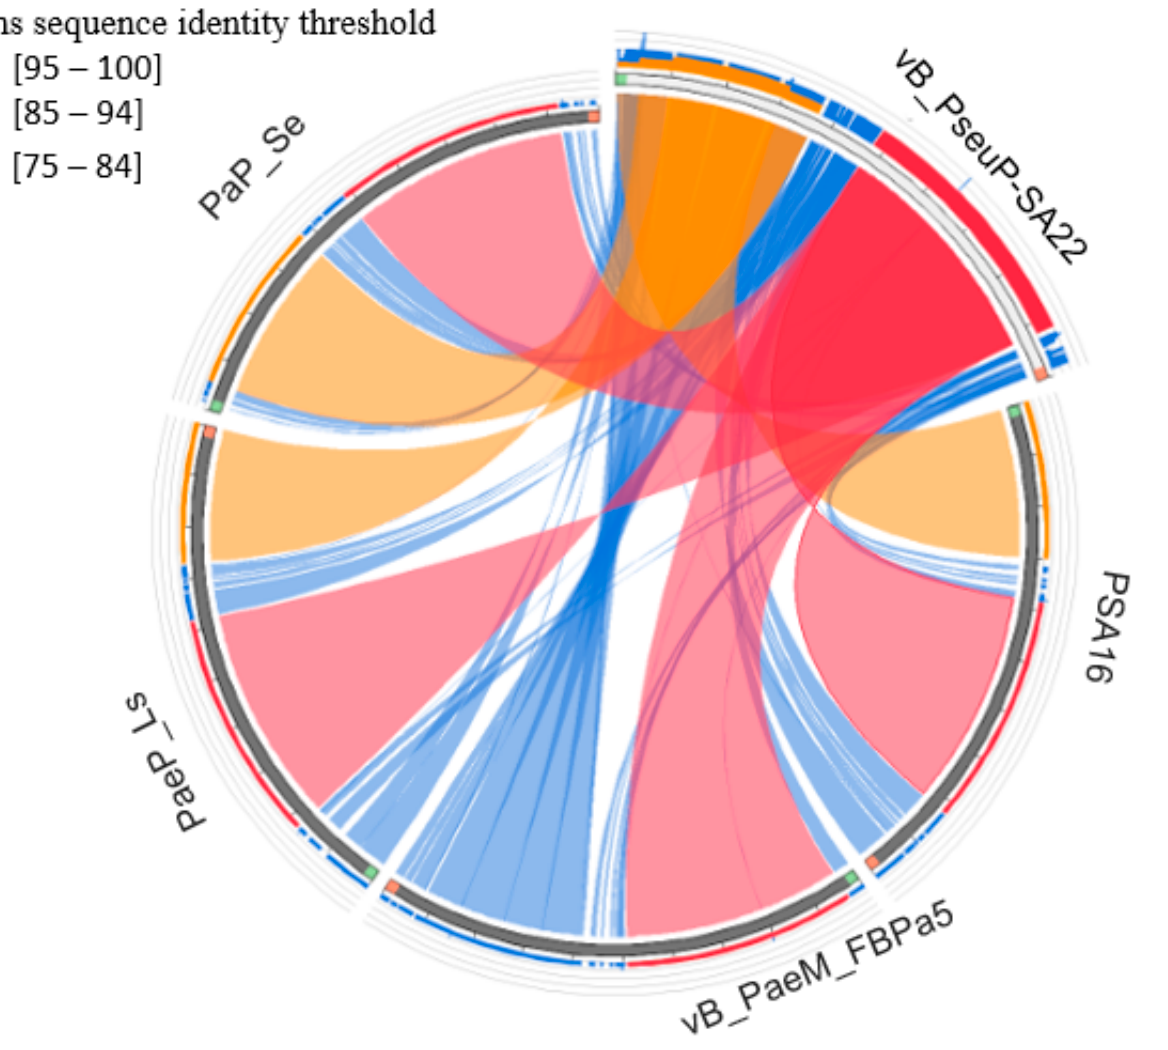
Figure 7. Circos plot showing the whole-genomic comparison of five Pseudomonas phages (including vB_Pseu-SAS22) in five different quadrants. The colored ribbons found inside the circle denote the local BLAST alignments, representing the different levels of the maximum score, as indicated in the legend.